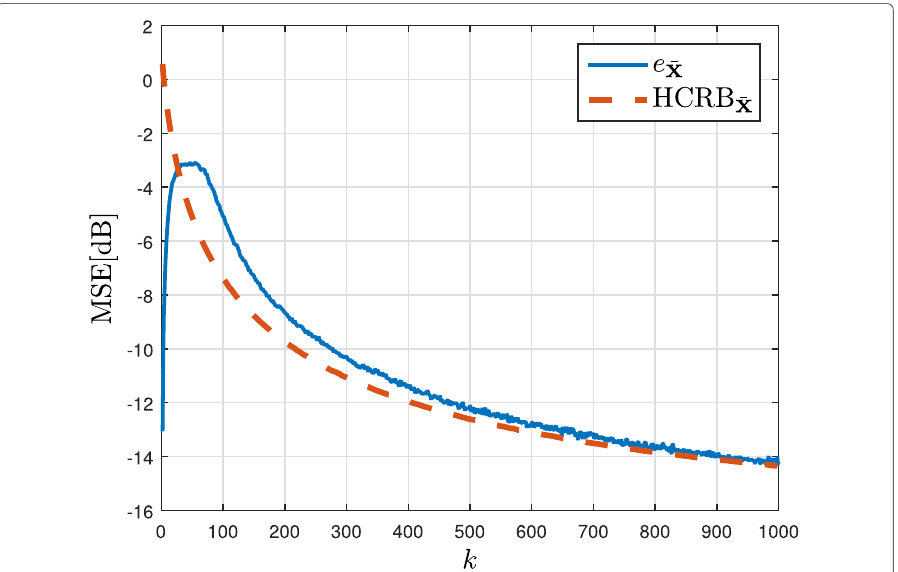
This is not the case for the randomly initialized room geometry parameters as depicted in Figs. 3 and 4.